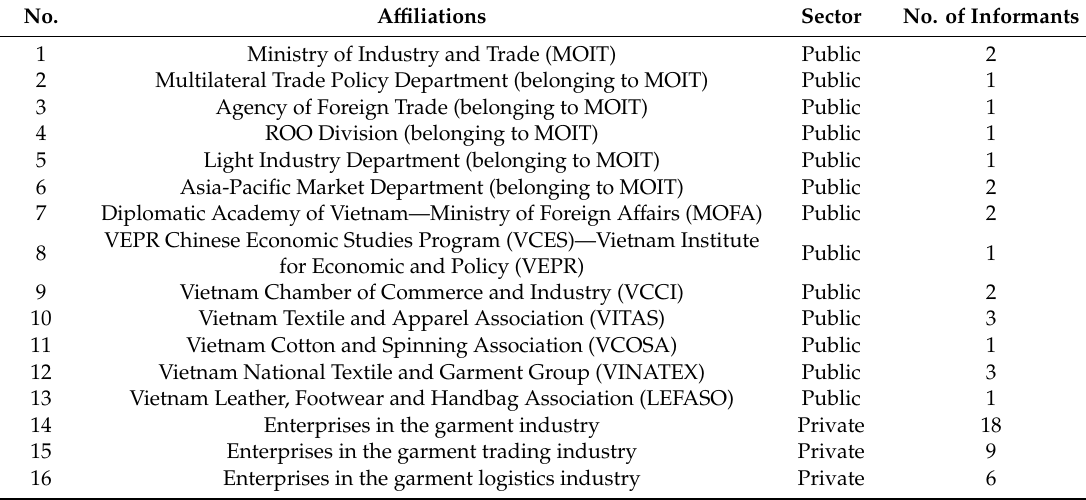
Table 1. Organizations that are involved in the